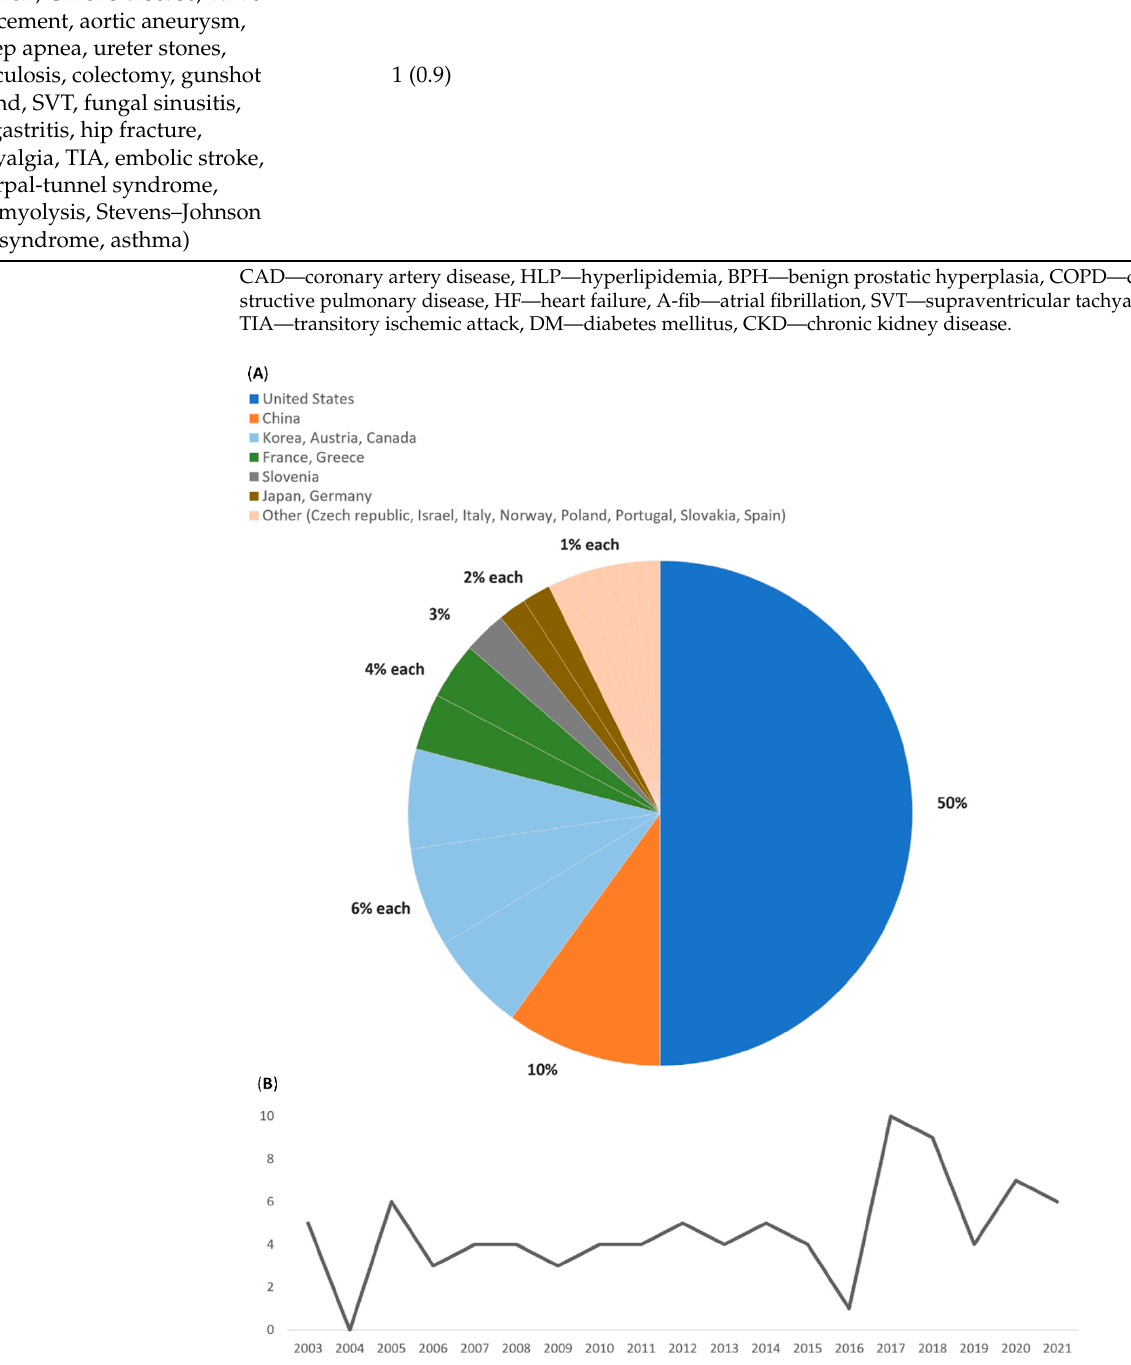
Figure 2. ( A ) List of countries where the case reports originated. ( B ) Number of article years.